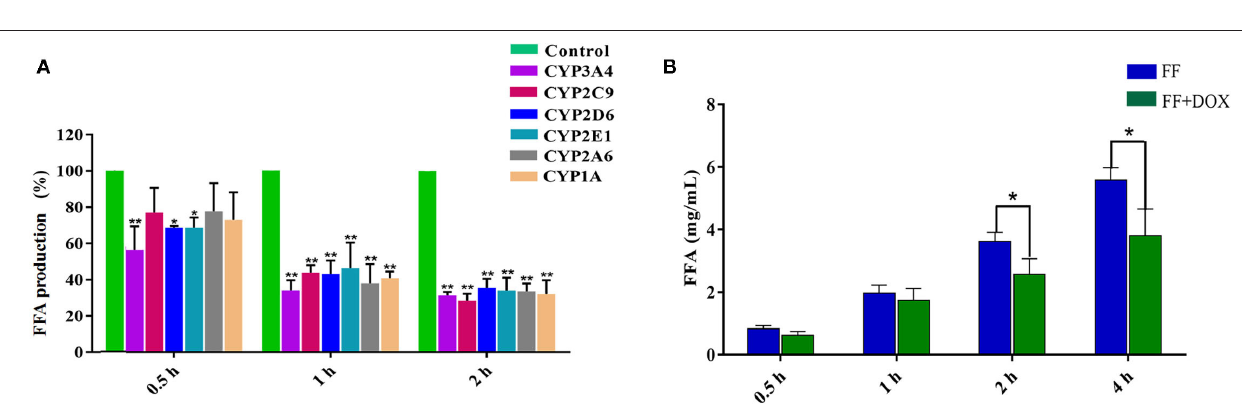
FIGURE 2 | The influence of specific inhibitors of CYP450 [ketoconazole (CYP3A4), diosmetin (CYP1A), quinidine (CYP2D6), fomepizole (CYP2E1), methoxsalen (CYP2A6) and sulfaphenazole (CYP2C9)] on the generation of FFA (A) . The effect of DOX on the metabolism of FF in goat liver microsomes (B) . (A) The horizontal axis represents the incubation time, and the vertical axis represents the FFA production in the inhibitor group to that in the control group. (B) The horizontal axis represents the incubation time of the drug and goat liver microsomes, and the vertical axis represents the amount of FFA produced. The results were expressed as mean ± standard deviation (error bars) and repeated three times of each reaction. P < 0.05 (*) was considered to be statistically significant. P < 0.01 (**) was considered a significant